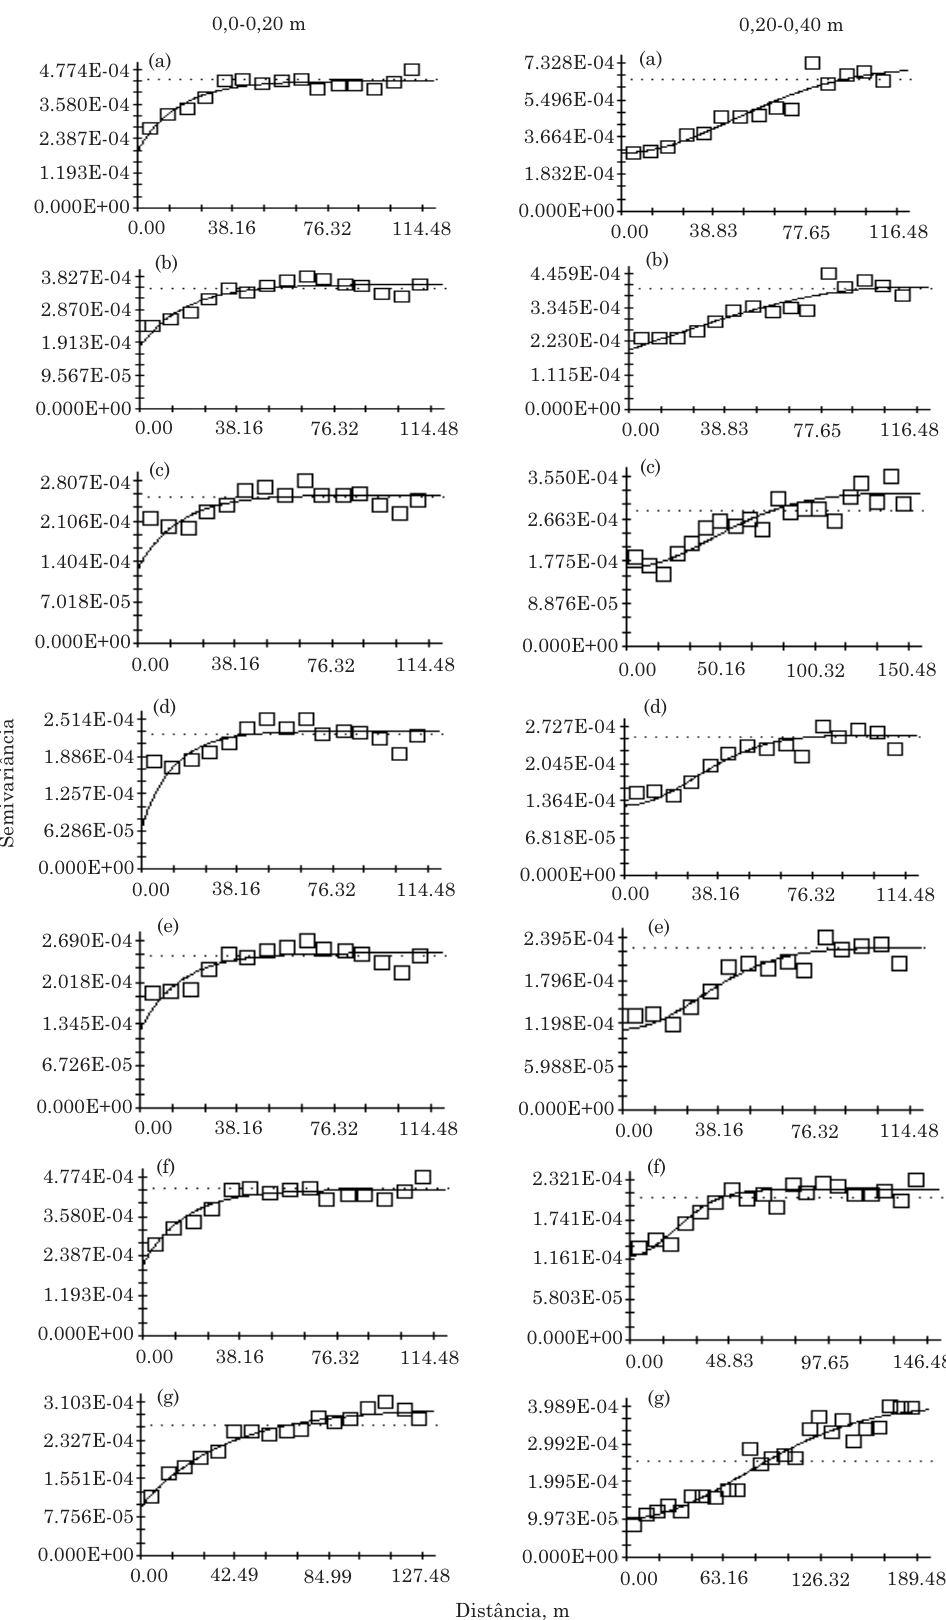
Figura 3. Semivariograma da umidade do solo à tensão de 0.006 MPa (a), 0.010 MPa (b), 0.033 MPa (c), 0.06 MPa (d), 0.1 MPa (e) e 1.5 MPa (f) e da água disponível (g), nas camadas de 0,0-0,20 e 0,20-0,40